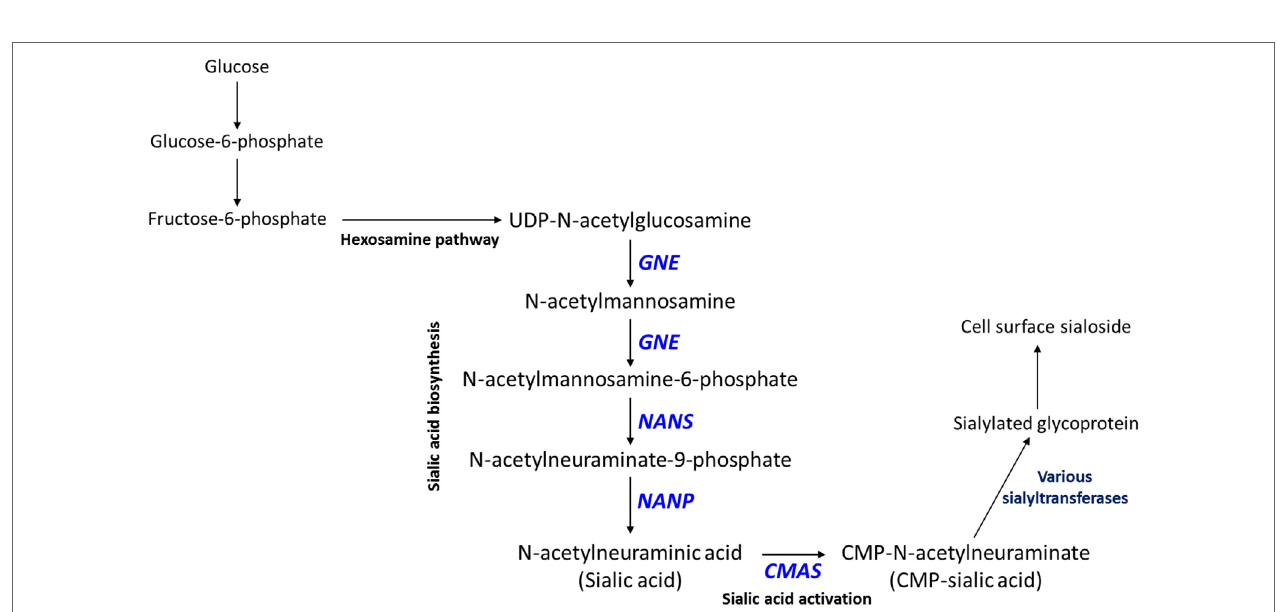
FigUre 2 | Sialic acid metabolic pathway. Sialic acid biosynthesis begins from uridine diphosphate (UDP)-N-acetylglucosamine, which is produced via the hexosamine pathway. GNE catalyzes the first committed step in sialic acid biosynthesis. Sialic acid is activated by coupling to cytidine monophosphate (CMP) via the action of CMAS , which produces CMP-sialic acid. CMP-sialic acid is used by sialyltransferases for sialylation of glycoproteins, which are then exported to the cell surface.